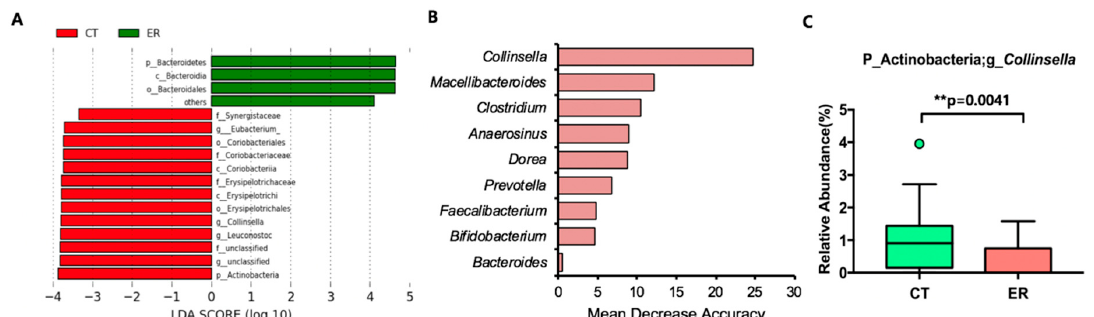
Figure 3. Featured taxa based on LDA effect size (LEfSe) analysis and random forest predictive analysis of CT and ER groups. ( A ) Selected taxa based on LEfSe analysis. ( B ) Selected taxa based on random forest analysis of the top 20 abundant genera. ( C ) Relative abundance of the genus Collinsella.